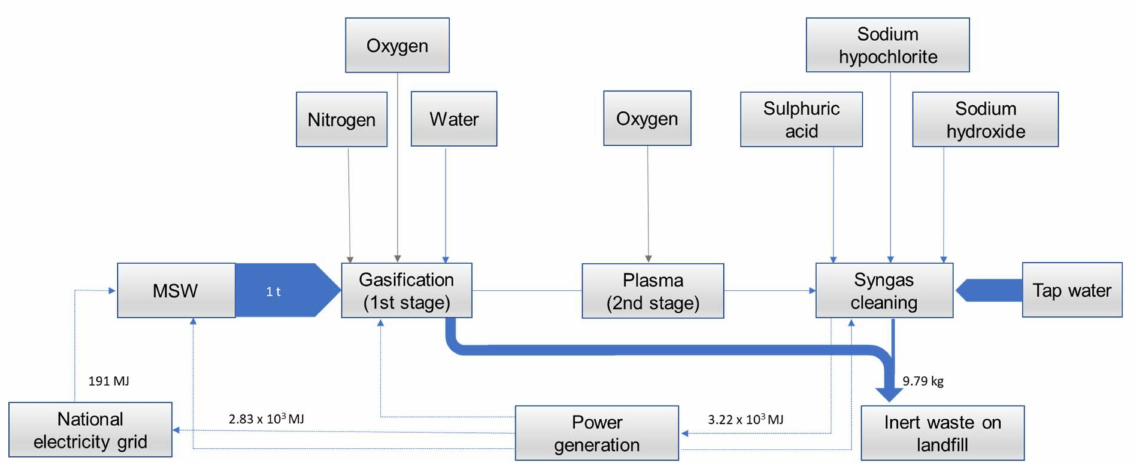
Figure 3. Two-stage plasma gasification plan for the present life cycle assessment (LCA)